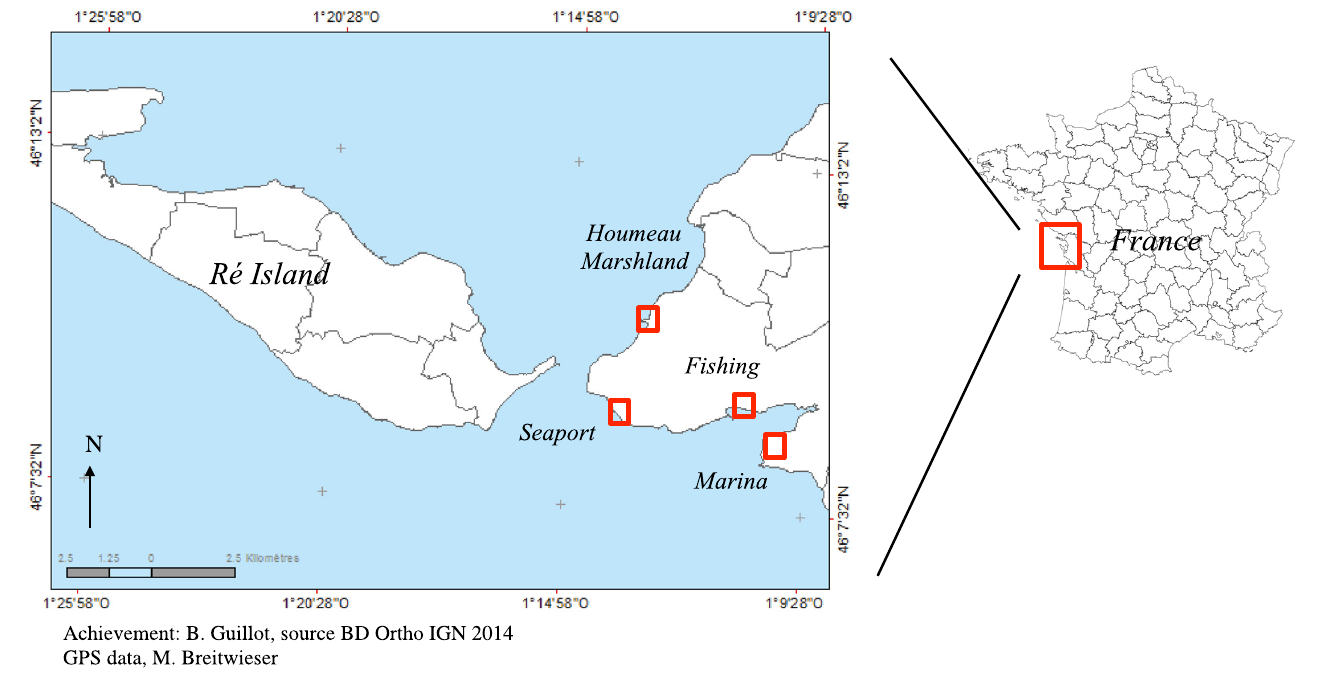
Fig 1. Map of France with the locations of the study areas. Four sampling sites are presented: Houmeau Marshland which is the less-contaminated area with the three habours (Marina, Fishing Harbour and Seaport).